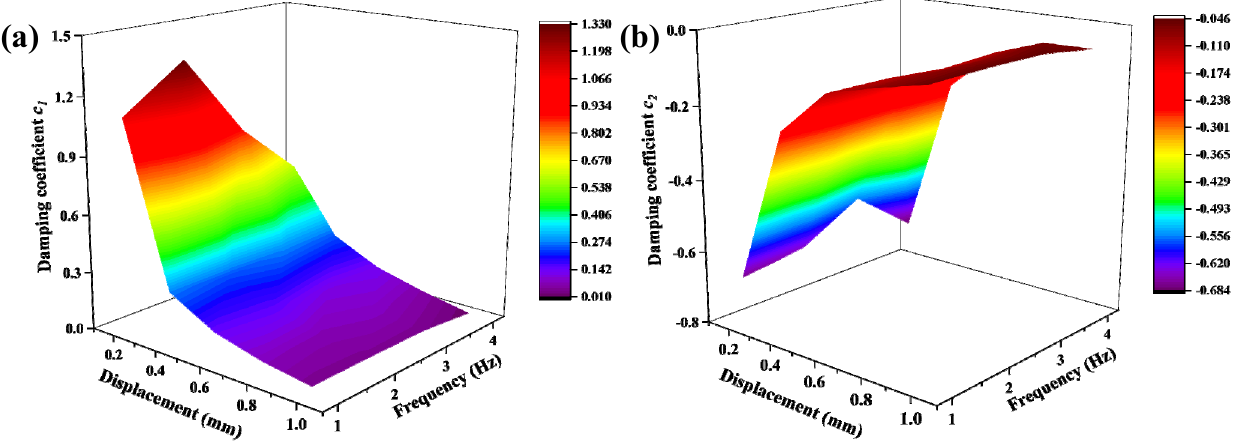
Figure 5. Variation trend of damping coefficient with amplitude and frequency ( a ) c 1 and ( b ) c 2 .